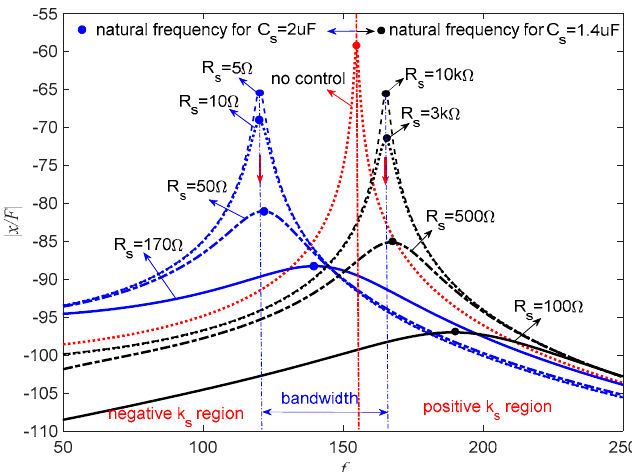
Figure 15. Frequency response of the piezoelectric stack transducer with negative capacitance in series with R s .